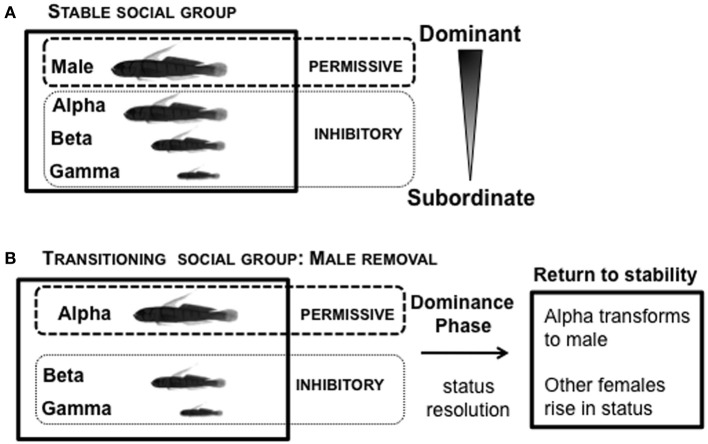
Social context of Lythrypnus dalli. (A) Stable social groups form a linear social hierarchy in the laboratory within 5 days. In the presence of the male, all females are in an environment inhibitory to sex change. (B) Sex change can then be readily induced in the alpha female by removing the male, which changes the social context. The most dominant female is now in a transitioning social environment that is permissive for sex change, while the subordinate females are in an environment inhibitory for sex change. Depending upon the specific group, there is substantial variation in the time over which a stable social hierarchy is re-established (“Dominance Phase”), after which there is a decline in rates of agonistic interactions.